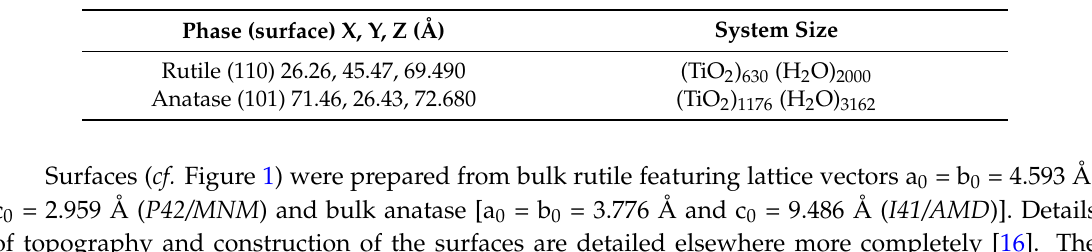
Table 2. Simulation-box dimensions and number of